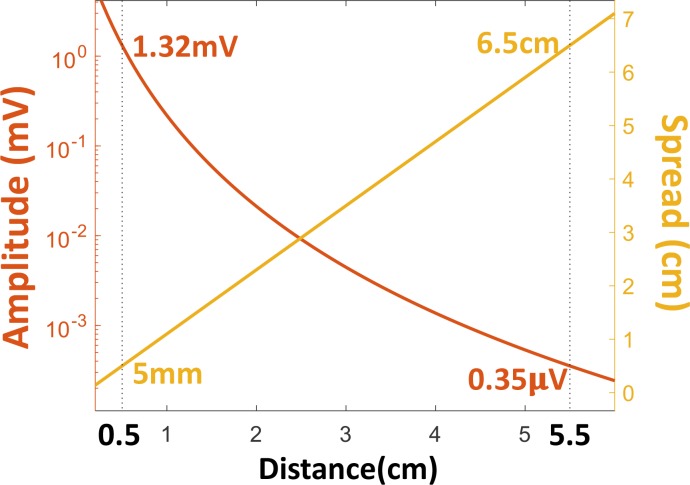
The amplitude (left ordinate, log scale) and spread (right ordinate, linear scale) of the object’s electric image on the skin, as functions of distance, based on a previously published model of electric fields in this fish (Chen et al., 2005).